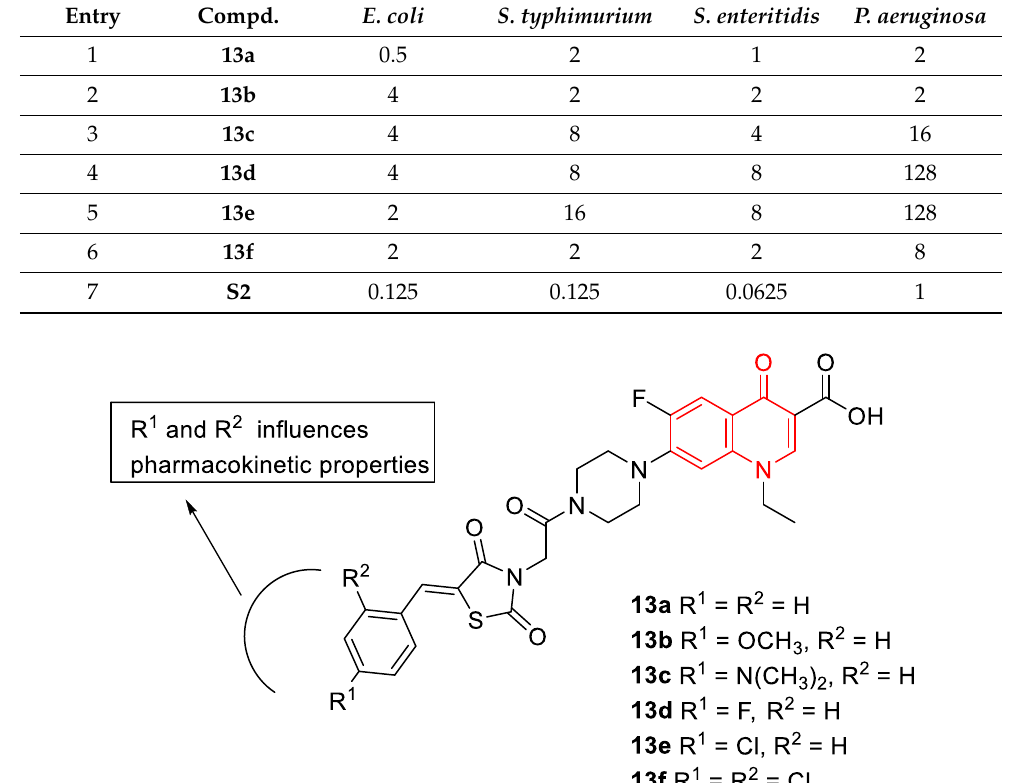
Table 2. MIC ( µ g/mL) values of compound 13a–f .